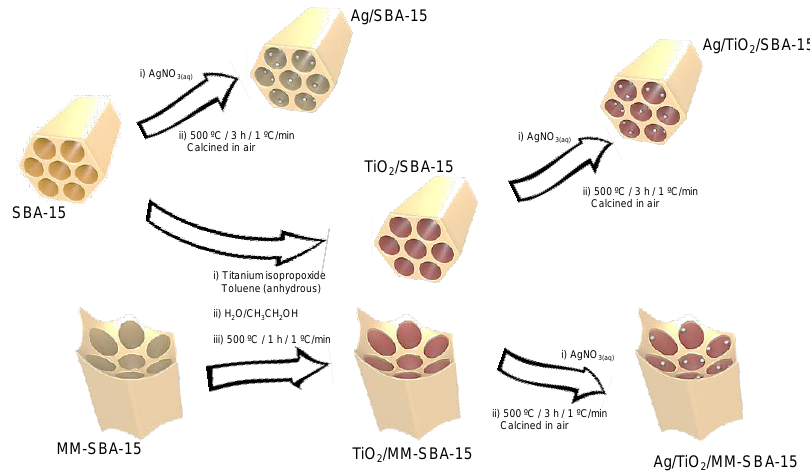
Figure 1 . Synthesis of Ag-doped mesoporous silica and titania-functionalized mesoporous and mesoporous-macroporous silica materials.